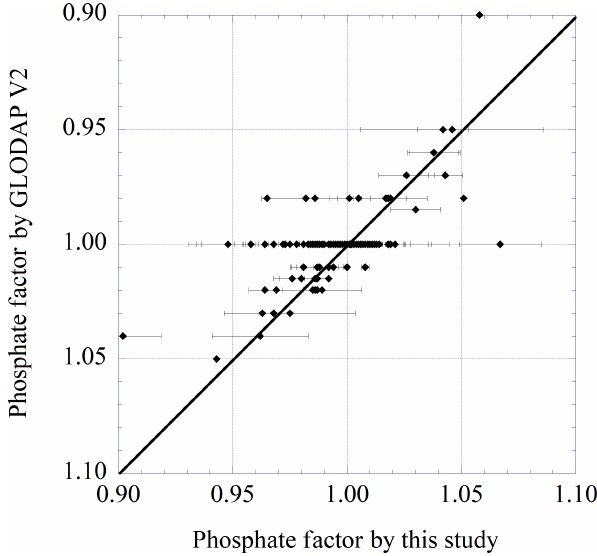
Figure 11. Same as Fig. 7 but for dissolved oxygen